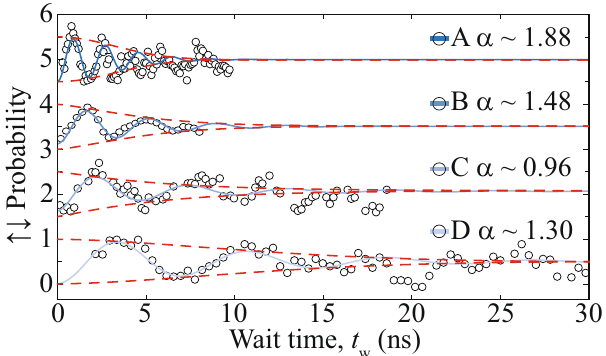
Fig. 4 Impact on charge noise on the determination of optimal exchange-gate operating conditions. Normalised oscillations of the experimentally measured two-spin probability (open circles, offset for clarity) of the up-down state as a function of the detuning-pulse wait time t w with a two-qubit donors-in-silicon system from He et al. 7 . The four sets of oscillations correspond to four different detuning positions (A-D) as outlined in Table 1. The decay of each Þ α (solid lines) oscillation was fi tted proportionally to exp ð t w = T SWAP 2 which shows how α can vary from 1 to 2 with detuning